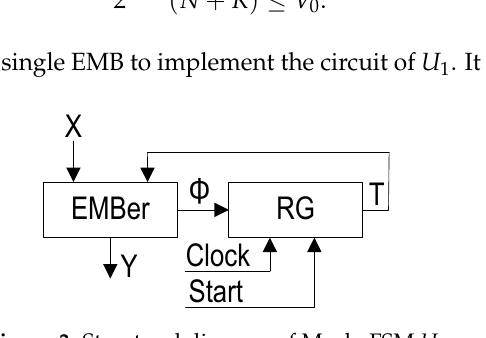
Figure 3. Structural diagram of Mealy FSM U 2